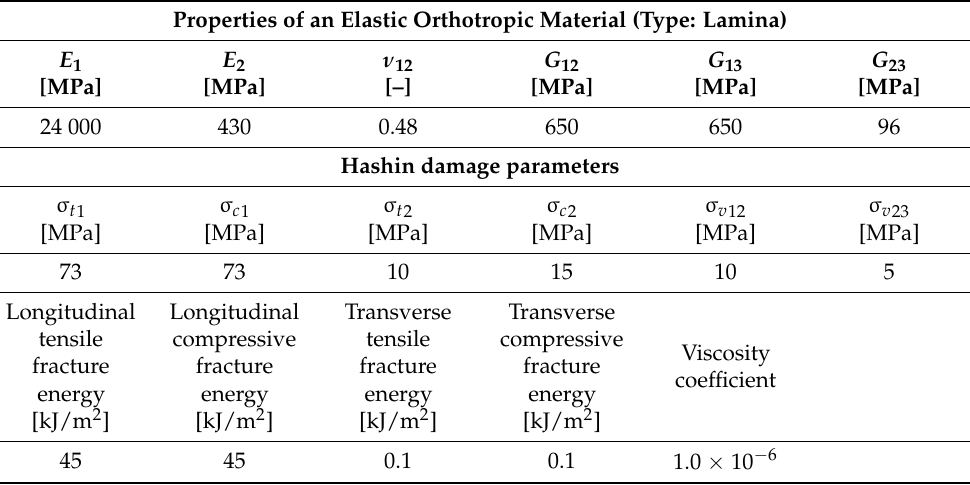
Table 2. The properties of the LVL adopted in the numerical models (direction 1 is parallel to the LVL